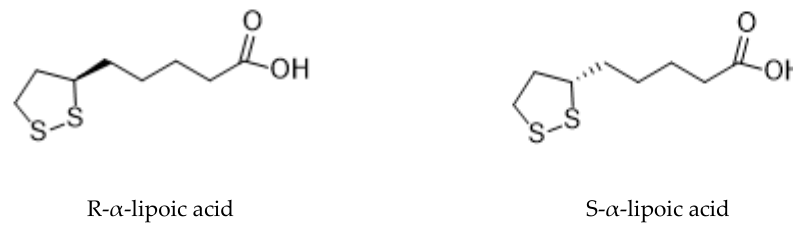
Figure 1. The chemical structure of optical isomers of ALA.